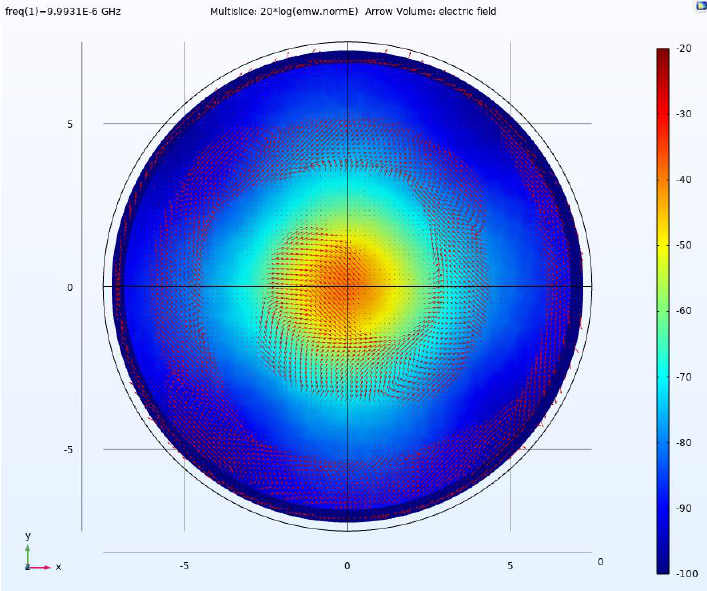
Figure 10. Electric field distribution and direction on the plane 20 km above the MD plane.